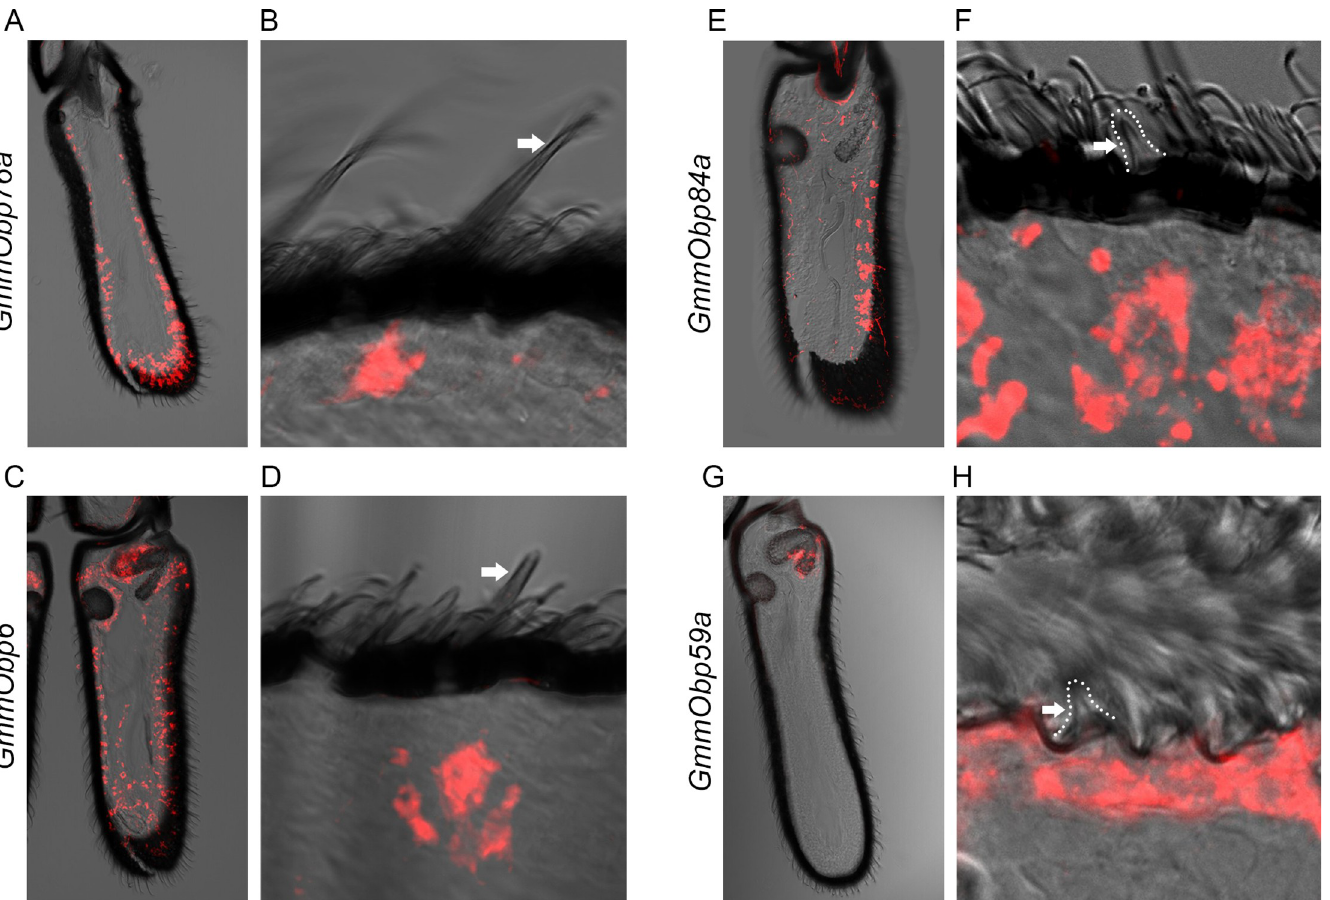
Fig 3. Expression of Odorant binding protein genes. (A, B) In situ hybridization to GmmObp76a in (A) 40 μ m and (B) 10 μ m antennal cross sections. Arrow in panel B marks a trichoid sensillum in the same plane as a cell body marked by GmmObp76a . (C, D) GmmObp6 in (C) 40 μ m and (D) 10 μ m antennal cross sections. Arrow in D marks a basiconic sensillum in the same plane as a cell body marked by GmmObp6 . (E, F) GmmObp84a in (E) 40 μ m and (F) 10 μ m antennal cross sections. Arrow in F marks a coeloconic sensillum in the ventral chamber of the sacculus in the same plane as a cell body marked by GmmObp84a . (G, H) GmmObp59a (red) in (G) 40 μ m and (H) 10 μ m antennal cross sections. Arrow in H marks a coeloconic sensillum in the same plane as a cell body marked by GmmObp84a